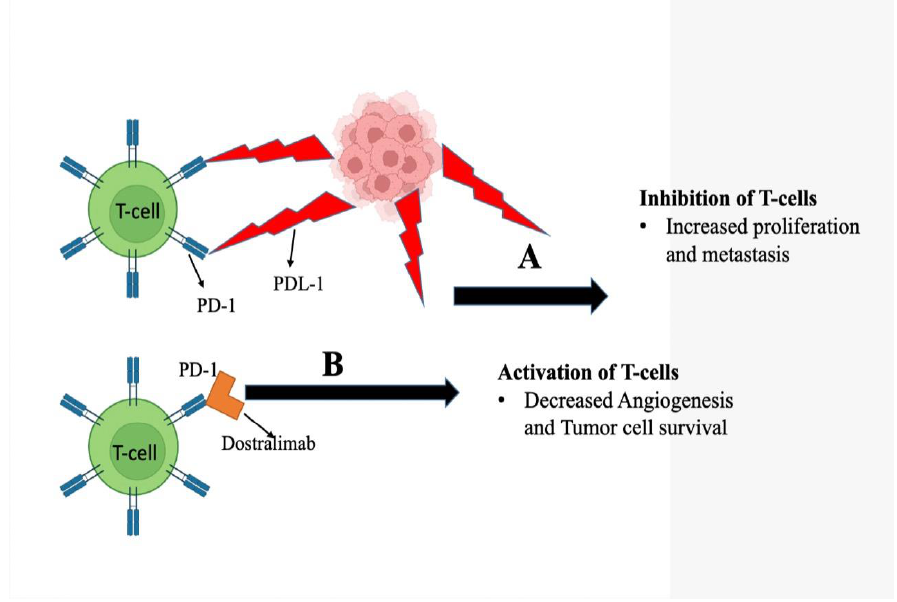
Figure 4. Diagram depicting the action mechanism of dostarlimab against cancer cells. The dostarlimab blocks the interaction of T cells over-expressing PD-1 protein with the PD-L1 present in cancer cells. ( A ) Cancer cells overexpress PD-L1 on their surface that interact with PD-1 of T cells. This disables the immune system from recognizing and targeting cancer cells. ( B ) Dostarlimab interacts with the PD-1 receptor on T cells, preventing their interaction with PD-L1 on cancer cells. This restores the T cells ’ cytotoxic function, allowing them to detect and kill cancer cells.